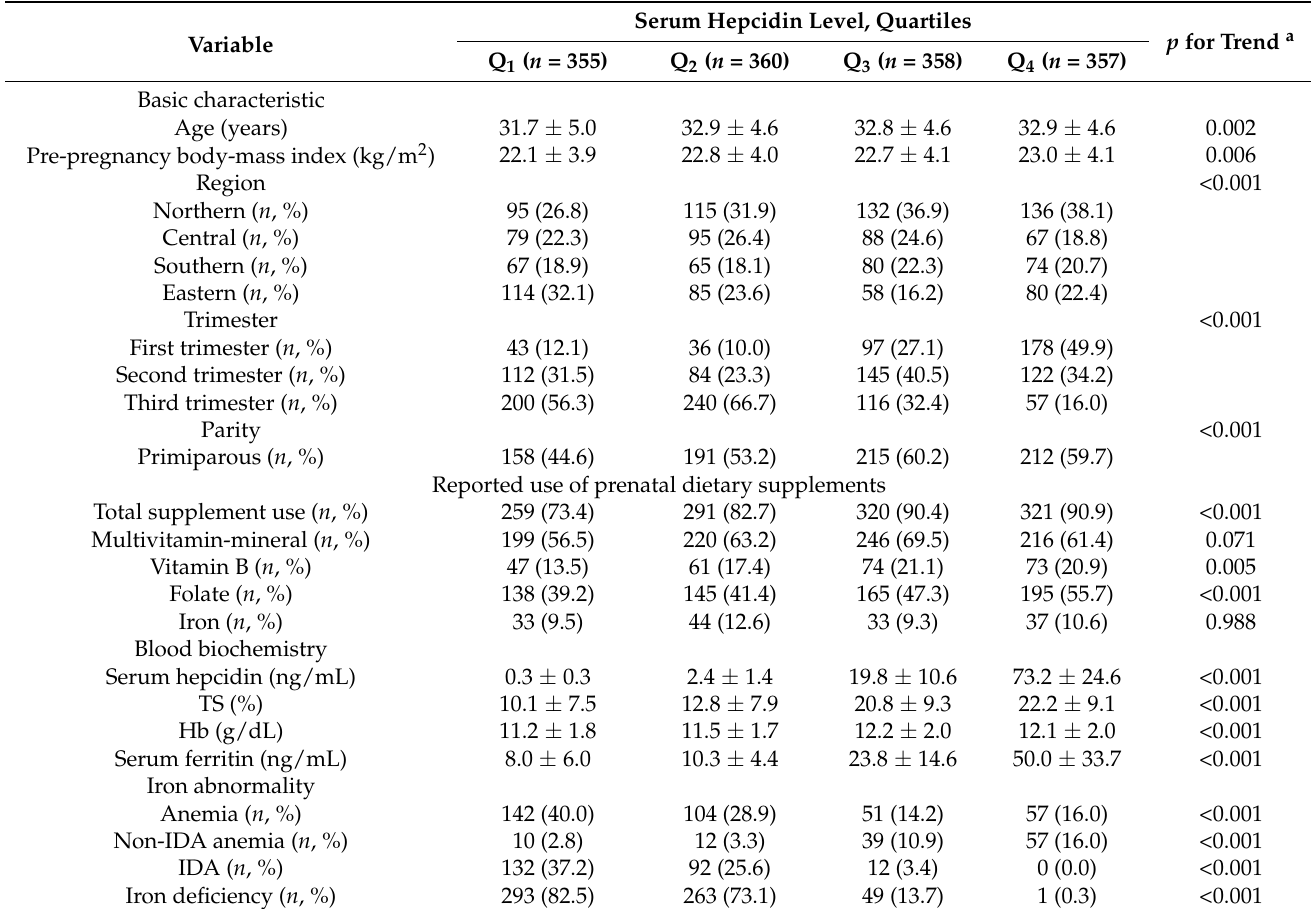
Table 1. Maternal baseline characteristics according to quartiles of serum hepcidin levels ( N =